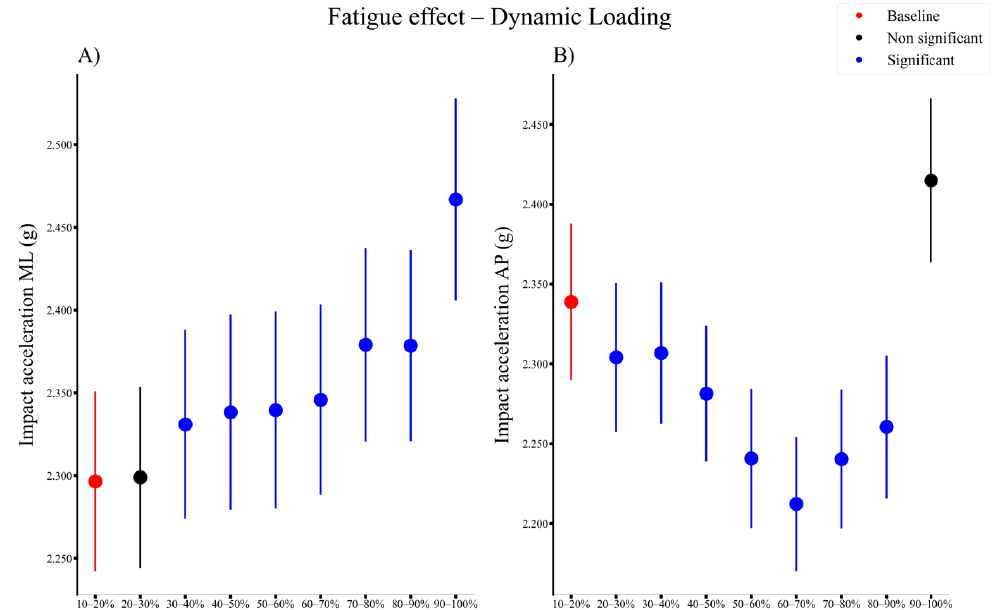
Figure 4. Time series of the overall significant fatigue effects (represented by blue dots) for dynamic loading measures (( A ) Peak impact acceleration in the mediolateral direction and ( B ) peak impact acceleration in the anteroposterior direction) for all participants, compared to the baseline (represented by red dots). ML, mediolateral, AP, anteroposterior.